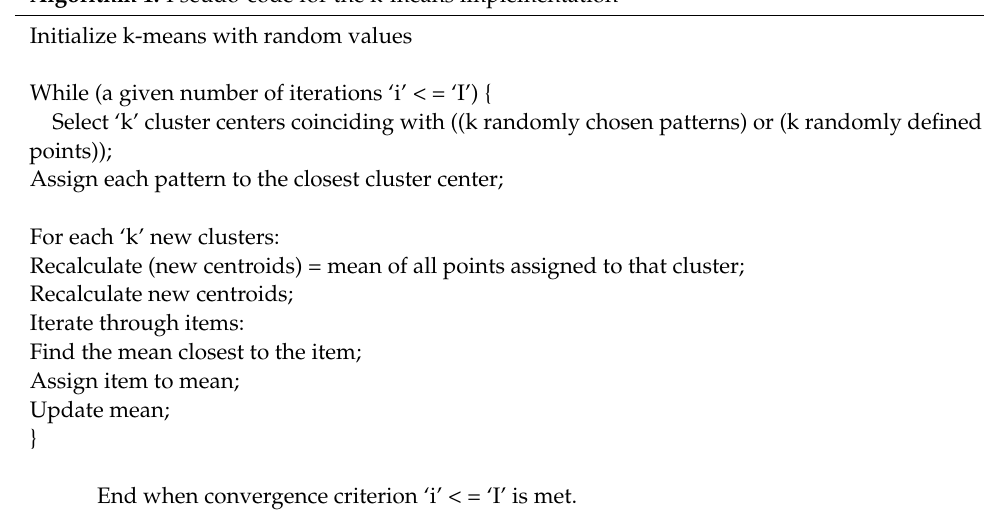
Algorithm 1: Pseudo-code for the k-means